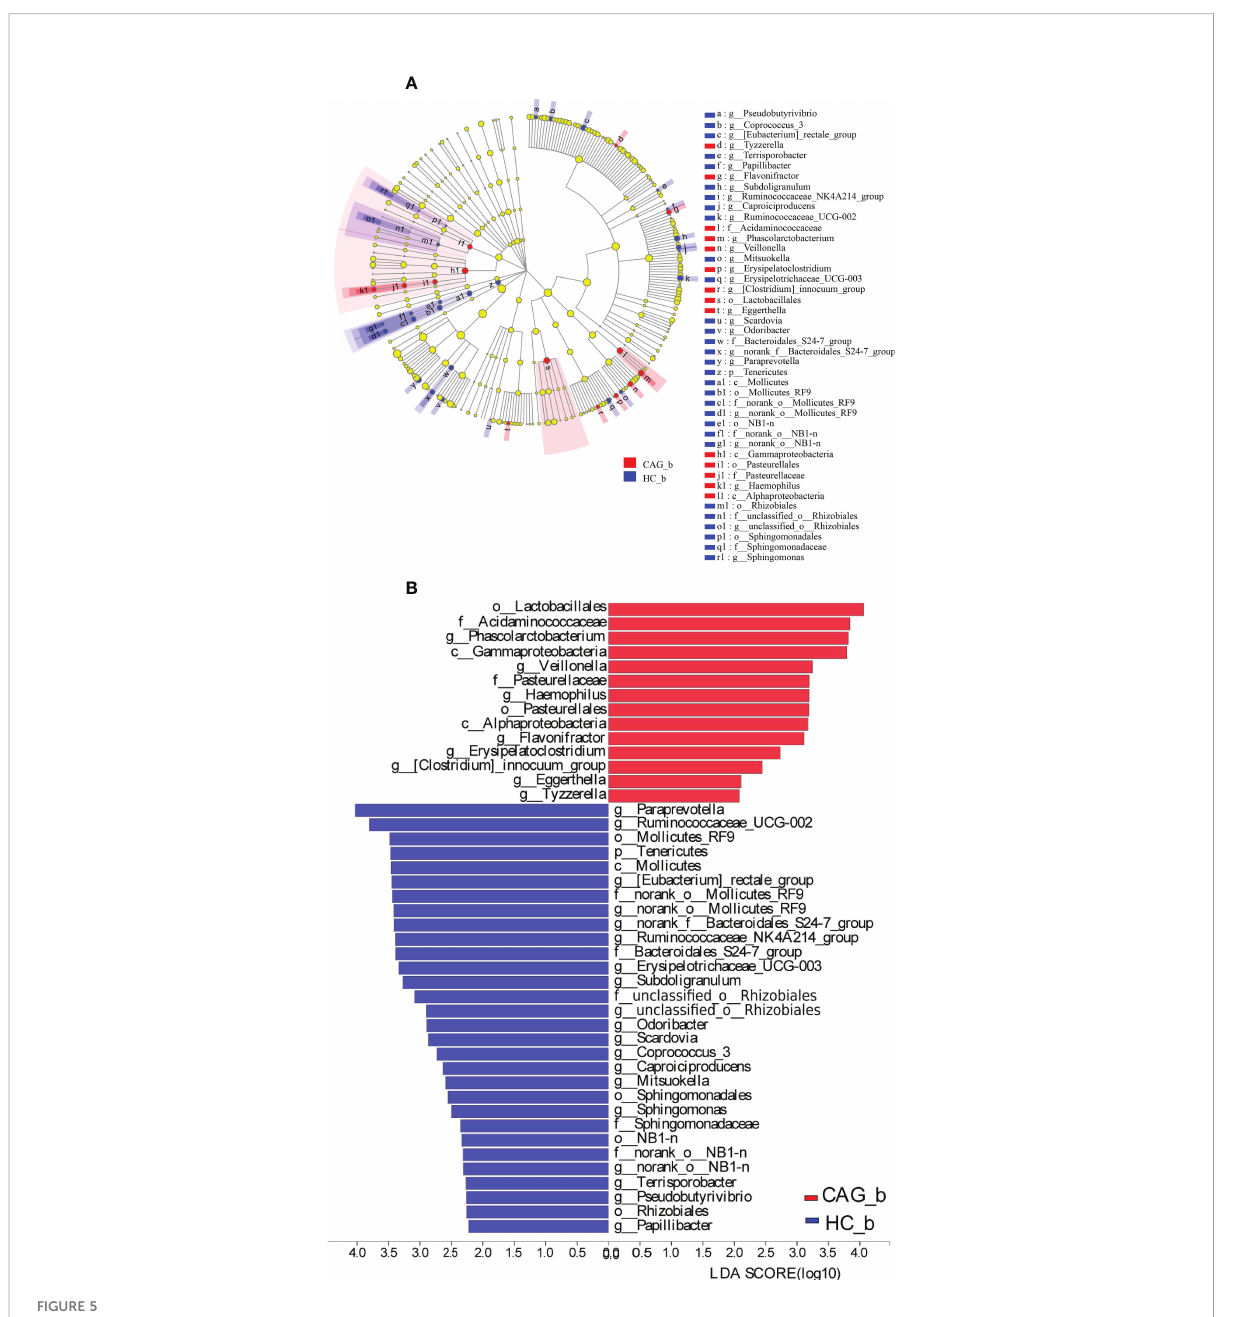
FIGURE 5 Enriched gut microbiota pro fi les in feces of CAG_b patients and/or HC_b healthy volunteers. (A) Cladogram plot: red nodes indicated signi fi cantly enriched bacterial colony with signi fi cant impact in CAG patients, and blue nodes indicated signi fi cantly enriched bacterial colony with signi fi cant impact in HC_b healthy volunteers. Light yellow nodes indicated bacterial colony without signi fi cant difference in both CAG patients and HC_b healthy volunteers. (B) LDA discriminant analysis histogram: red bar represented the bacterial colony enriched in CAG patients; blue bar represented the bacterial colony enriched in the HC_b healthy